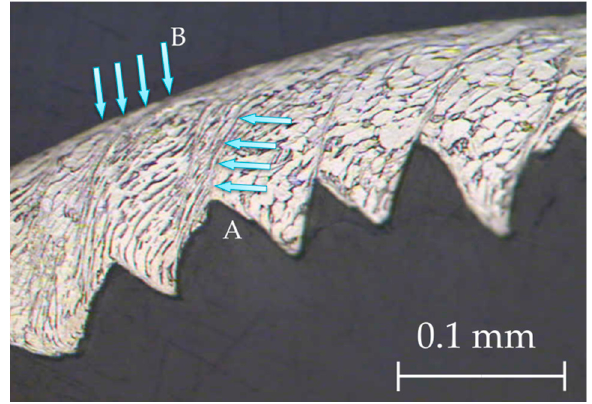
Figure 7. Grain deformation within the chip microstructure ( v c = 125 m/min, f = 0.10 mm/r).